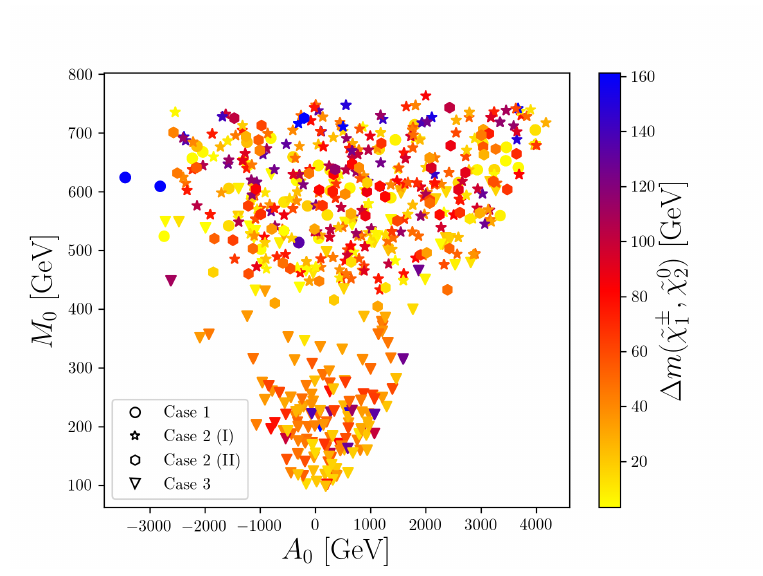
Figure 2 . A scatter plot in the M 0 - A 0 plane showing the three cases (and subcases) with the chargino-second neutralino mass gap shown on the color